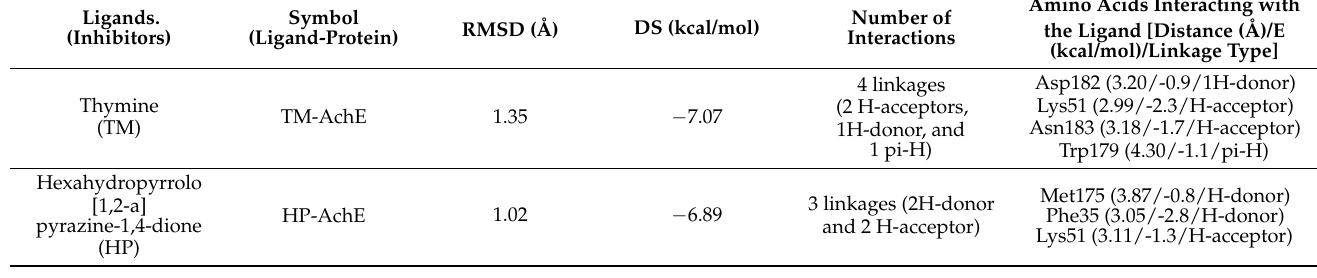
Table 2. The docking study results of the interaction of the two ligands with the target enzyme acetylcholinesterase (AchE).